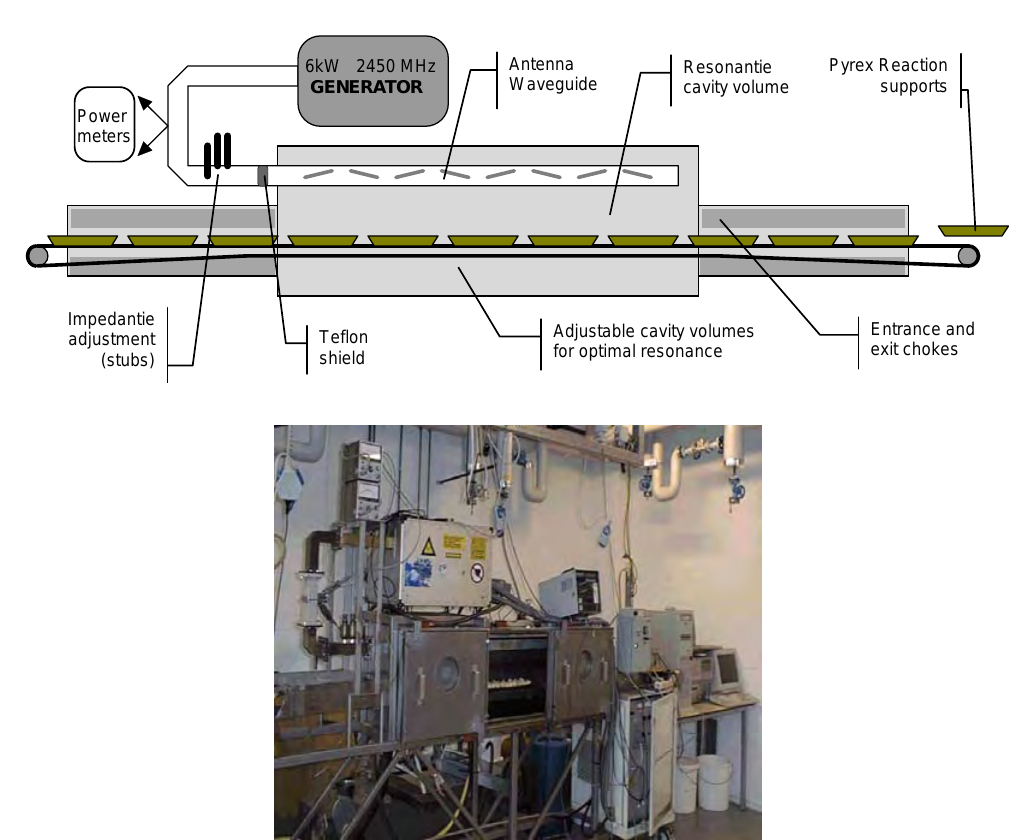
Figure 4. Schematic of a 6kW continuous microwave heterogeneous-media reactor. Total length 4